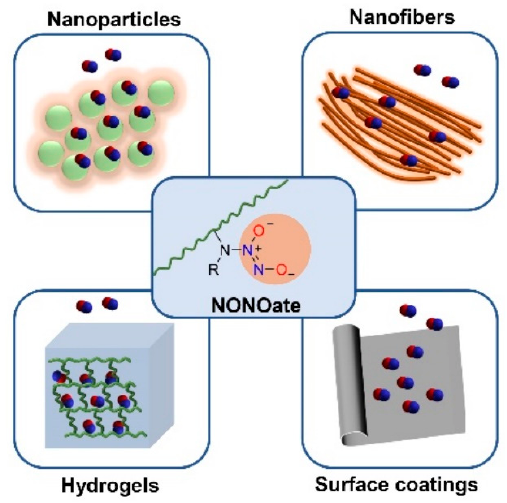
Figure 3. NONOate conjugated polymeric materials for antibacterial application: NO releasing hydrogels, reported in [95]; NO releasing nanoparticles, reported in [56,96,97]; NO releasing nanofibers, reported in [98]; NO releasing surface coatings, reported in